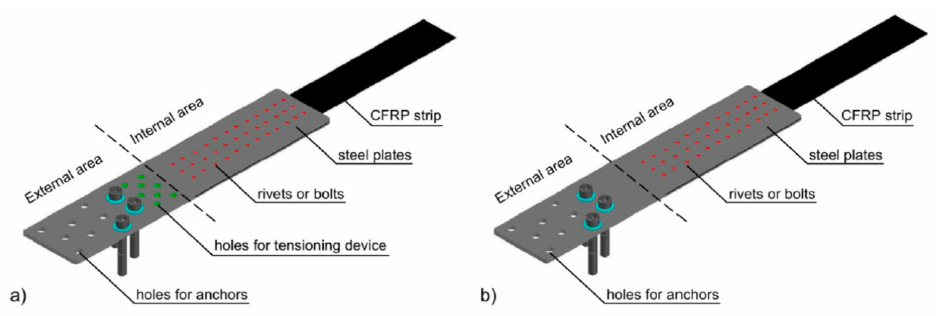
Figure 5. The NEOXE anchoring system: ( a ) active side and ( b ) passive side